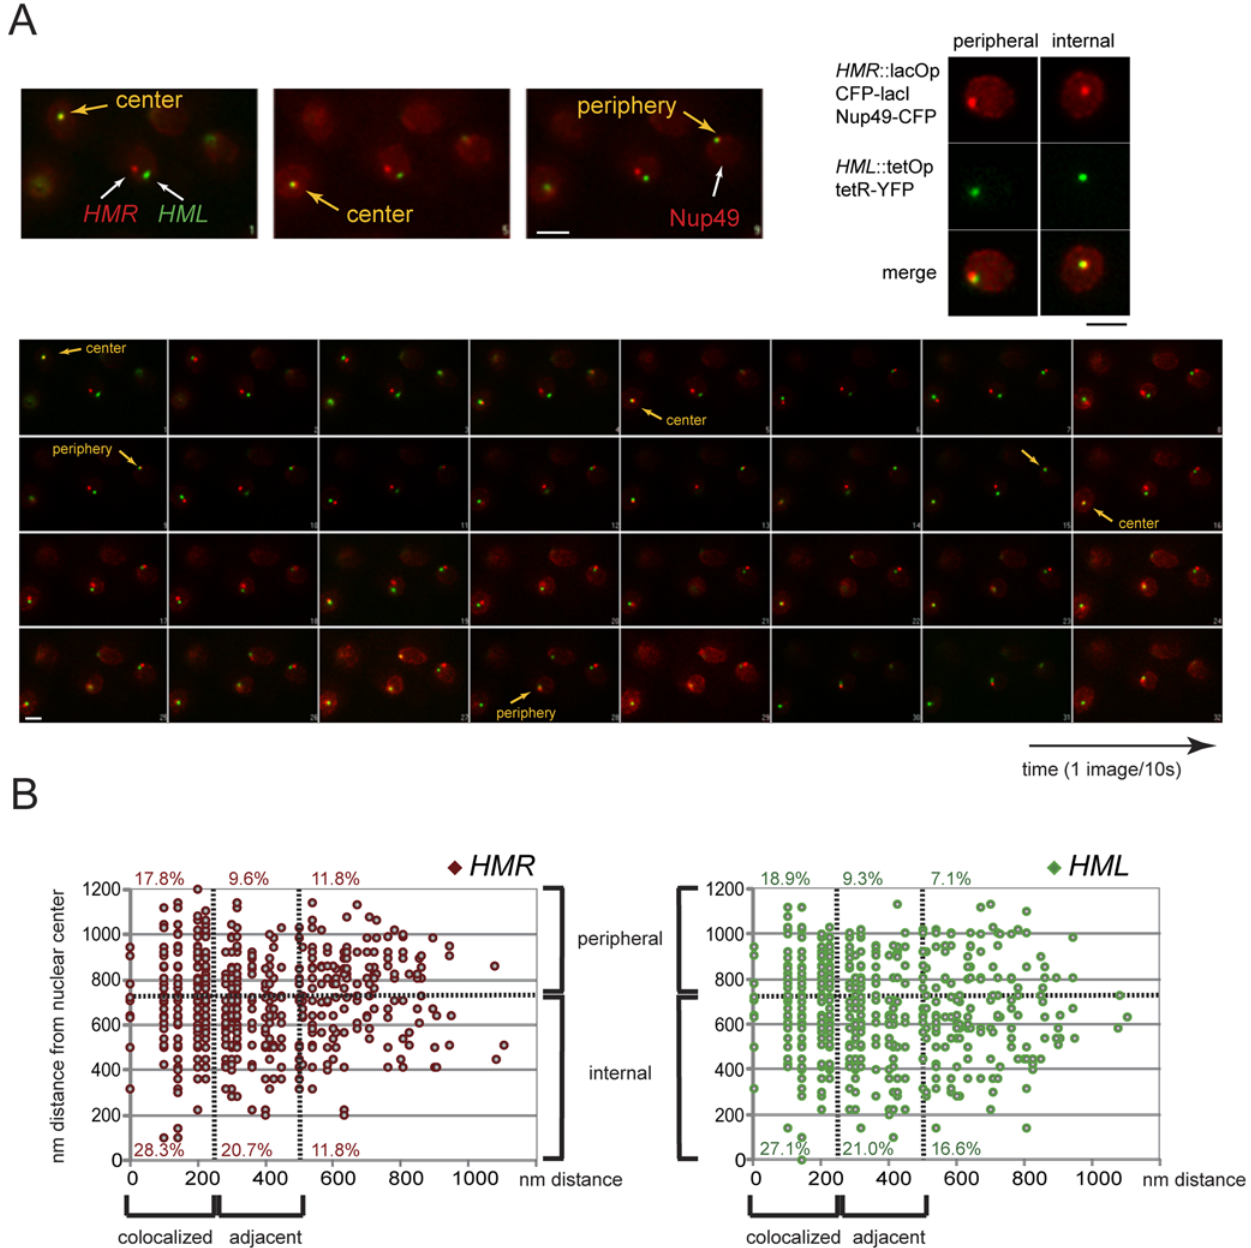
Figure 6. Interaction between HML and HMR is independent of peripheral anchoring. (A) Time lapse images of YFP and CFP tagged HML and HMR relative to the nuclear rim as identified by Nup49-CFP. Images were acquired on a wide-field Olympus XI microscope using a 100 6 objective (NA=1.4) every 10 s for 320 s without changing the focal plane. Acquisition times were 400 ms for each wavelength. HML and HMR colocalize transiently near the periphery or in the center of selected nuclei (yellow spots). Bar is 1 m m. (B) Position of HML and HMR relative to the nuclear center inferred from tetR-YFP nuclear fluorescence in single nuclei over time taking images in 2D every 1.5 seconds on a confocal LSM510 microscope plotted against the distance between HML and HMR at every time point during 1–3 min time lapse movies. Colocalization was assigned for distances , 250 nm, juxtaposition for distances , 500 nm (adjacent). The interior fraction corresponds to a position of HML or HMR at less than 720 nm from the nuclear center, thus about 2/3 of the positions. The percentages represent the fraction of datapoints in any sector of the graph.